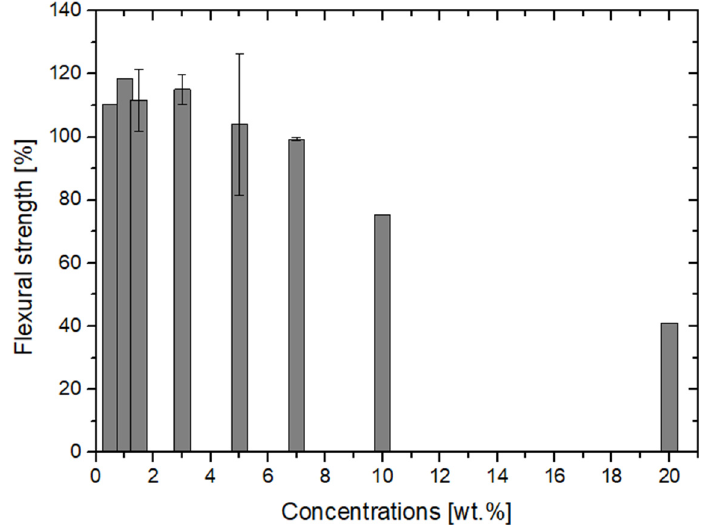
Figure 3. The effect of nano-ZrO 2 additive concentration on the flexural strength of PMMA composites. The average results for concentrations with variations.